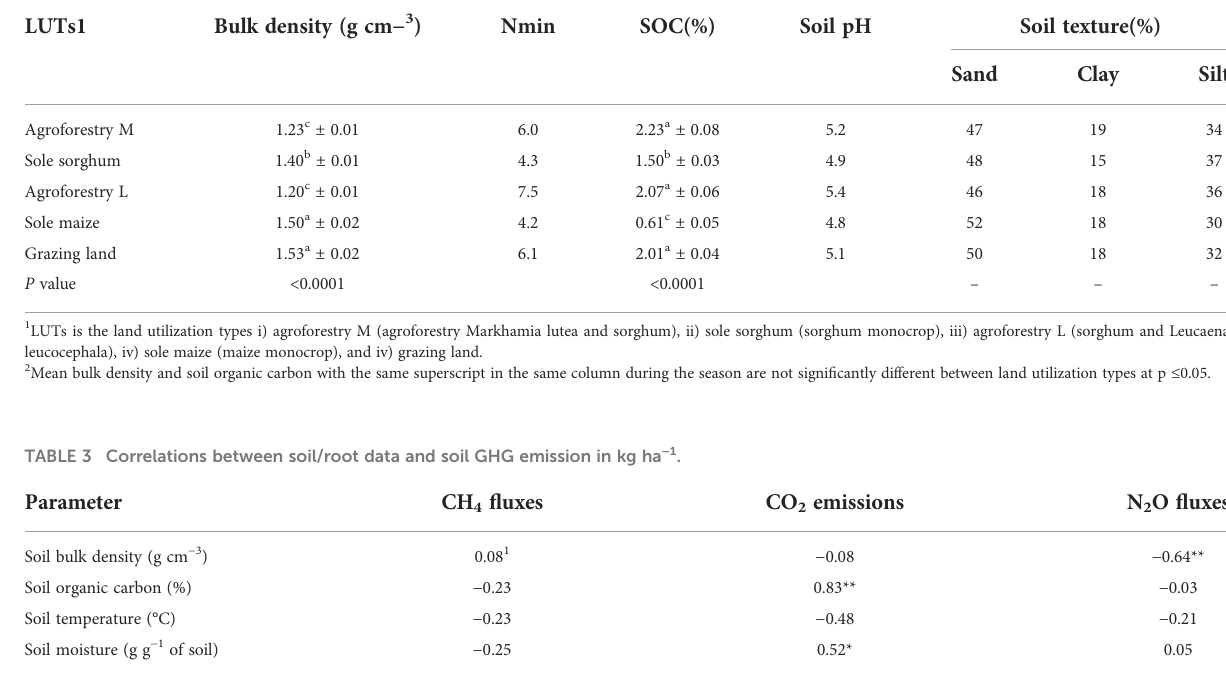
(Figure 3A). We observed high N 2 O fl uxes following precipitation events. The soil N 2 O fl uxes were mainly positive, but we observed few soil N 2 O uptakes, especially during the off-season.